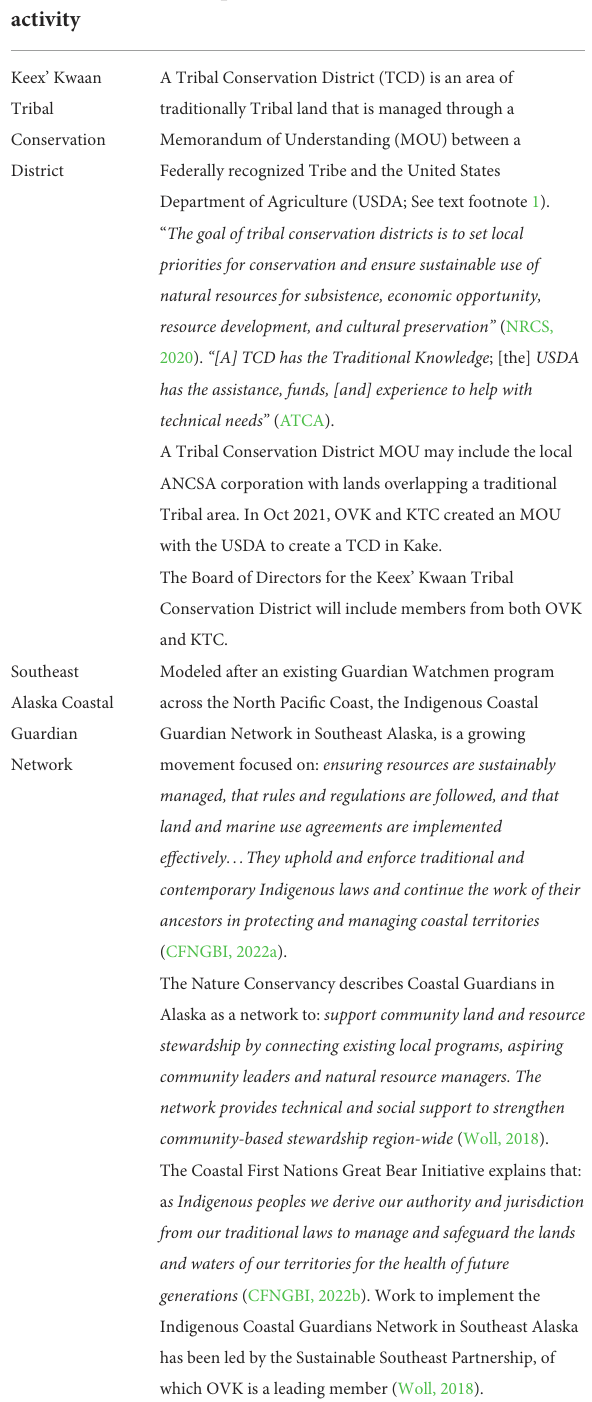
TABLE 2 Detailed descriptions of two ongoing activities in Kake related to the Kake Climate Partnership. Descriptions of two activities in Kake related to the